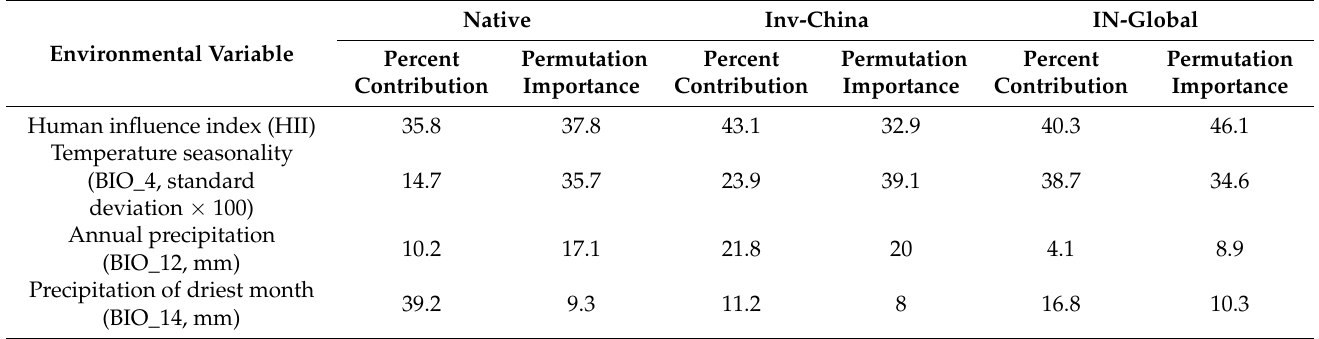
Table 2. Average percent contribution and permutation importance of environmental variables to different Ambrosia artemisiifolia models; values were averaged across 10 replicate